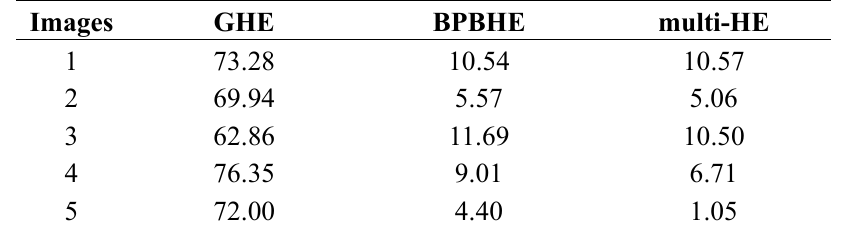
Table 1. The absolute mean brightness error (AMBE) value of the output images performed by GHE, BPBHE and multi-HE.